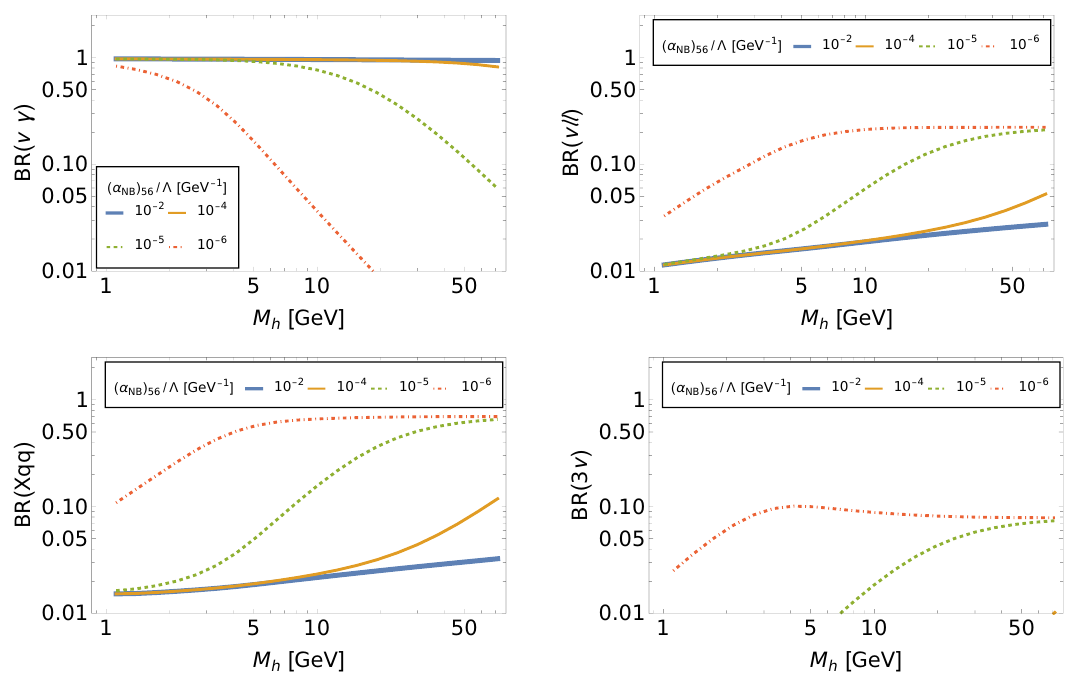
Figure 2 . Heavy neutrino branching ratios. Choice of parameters as in figure